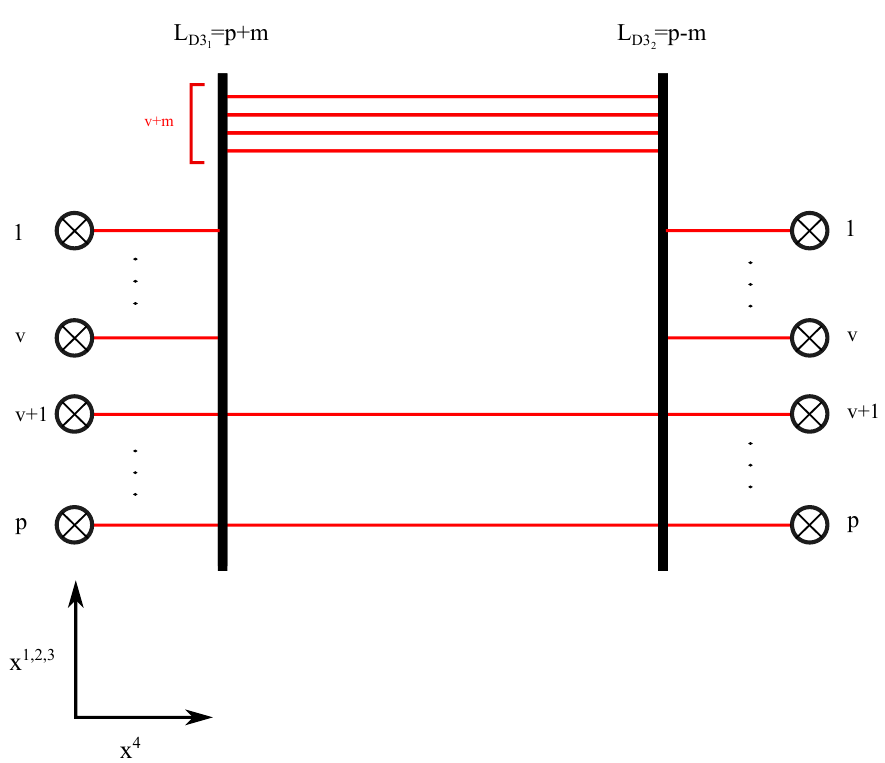
Figure 9 . D1-D3-NS5-brane con(cid:12)guration for bubbling monopole in a SU(2) theory in the sector v = diag( (cid:0) v; v ). The R 3 positions of the p pairs of NS5-branes are distinct. The R 3 positions of ( p (cid:0) v ) D1-branes coincide with the R 3 positions of ( p (cid:0) v ) pairs of NS5-branes, thereby